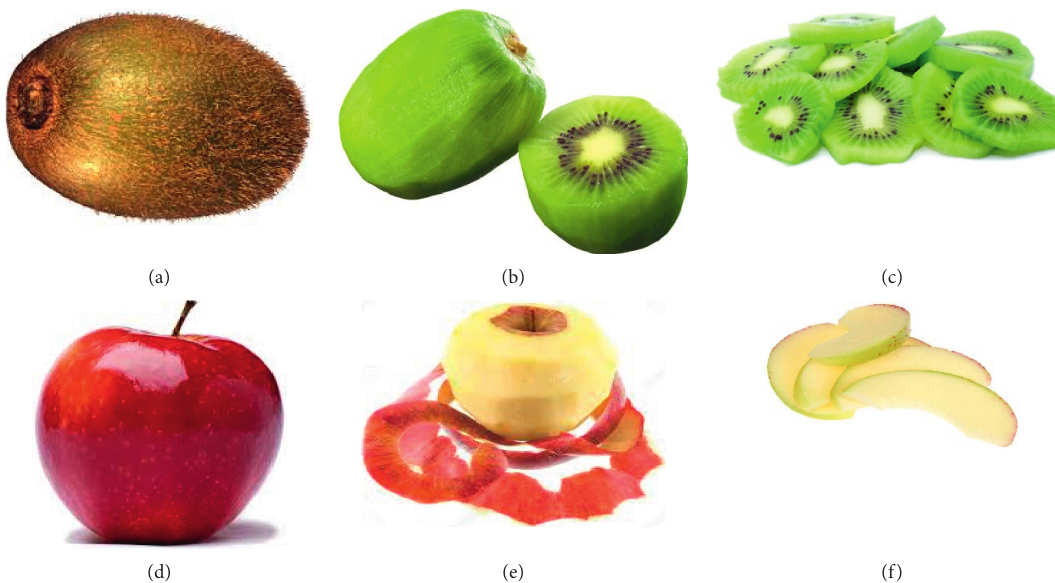
Figure 1: Minimal processing of fresh fruits and vegetables includes washing, peeling, and cutting.